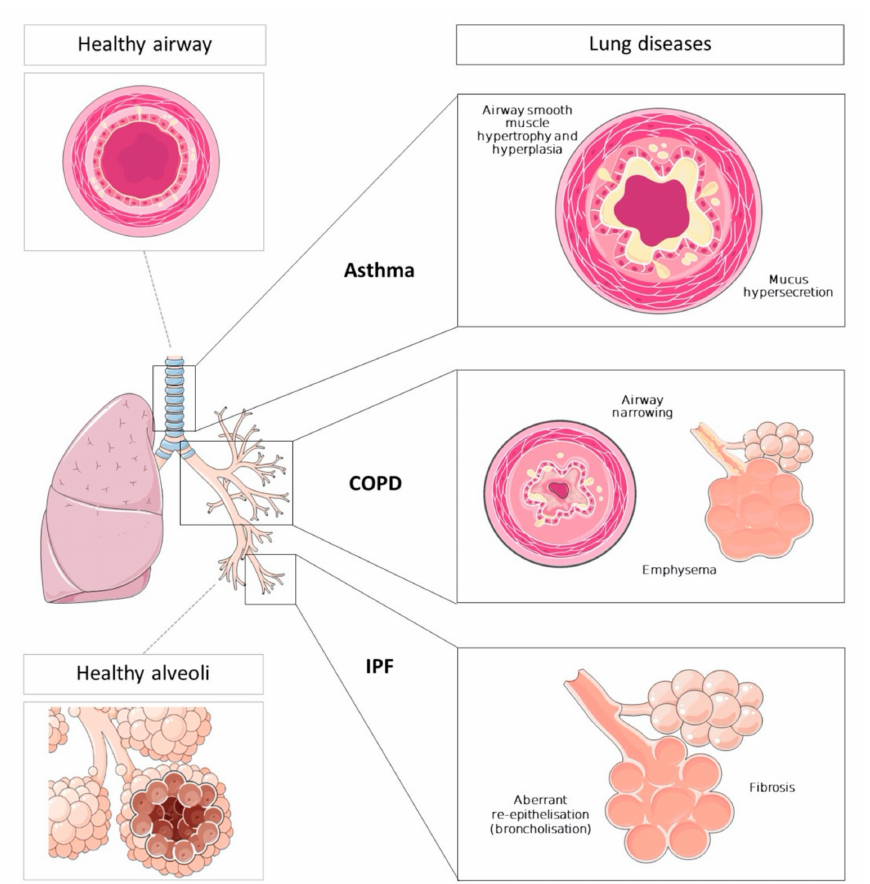
Figure 1. Overview of the main processes and events that occur in different regions of lung and airway in asthma, chronic obstructive pulmonary disease (COPD) and interstitial pulmonary fibrosis (IPF) patients, compared to healthy condition. Asthma involves mainly the upper airway promoting airway remodeling, which includes airway smooth muscle hypertrophy and hyperplasia, and goblet cell hyperplasia and consequent mucus hypersecretion. These processes cause reversible airway narrowing. COPD affects lower airways and lung parenchyma causing irreversible airway narrowing and alveolar disruption (emphysema) in the lungs. IPF affects only the lungs through excessive fibrosis processes with subsequent aberrant alveolar re-epithelisation (broncholisation). (Components of this figure have been obtained and modified from Servier Medical Art,